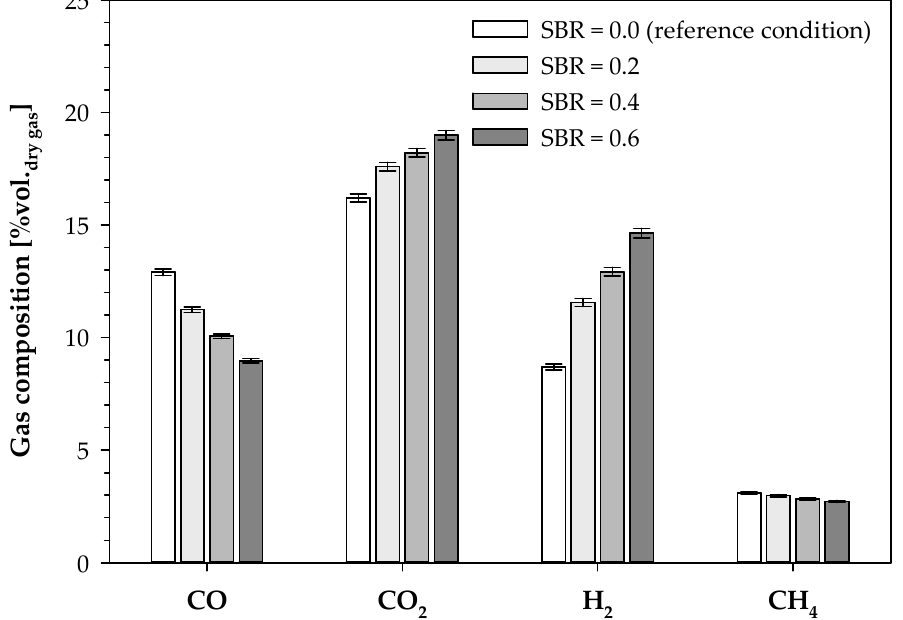
Figure 2. Effect of steam injection on the producer gas most abundant components concentration (N 2 concentration excluded) during air gasification of RFB from eucalyptus ( φ = 20 %vol. O ₂ , dry GA — Tables 3 and 4).